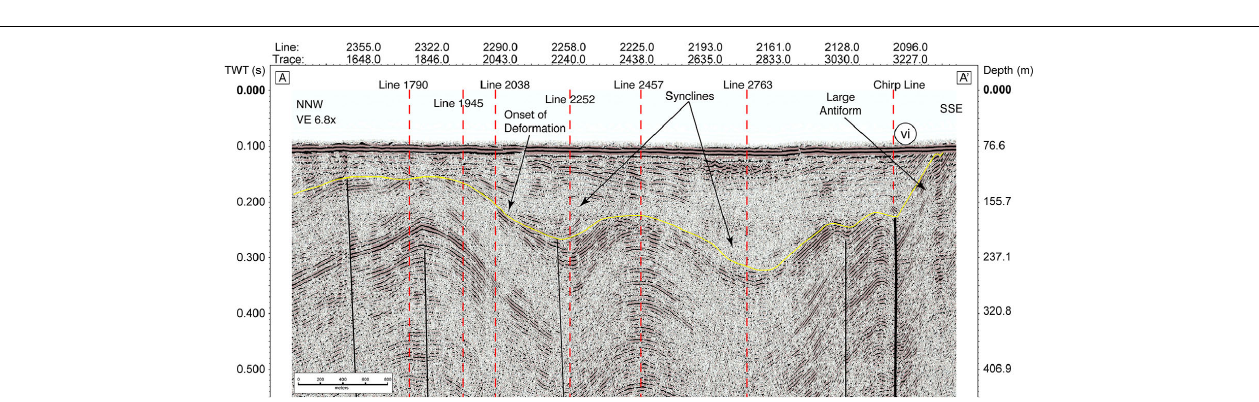
FIGURE 11 | Interpreted stair diagram of Crossline 4400 with major fault segments labeled. Crossline is bounded by time-slices at 125 and 350 ms ( ∼ 96 and ∼ 279 m), rendered using similarity data combined with amplitude data at 60% transparency. A smaller anticline is observed in the lower (350 ms) time-slice west of fault segment x. Note the monocline in the crossline north of fault segment xi. Green line traces stratigraphic horizon that records onset of deformation. Locations of seismic lines are shown in Figure 1C .